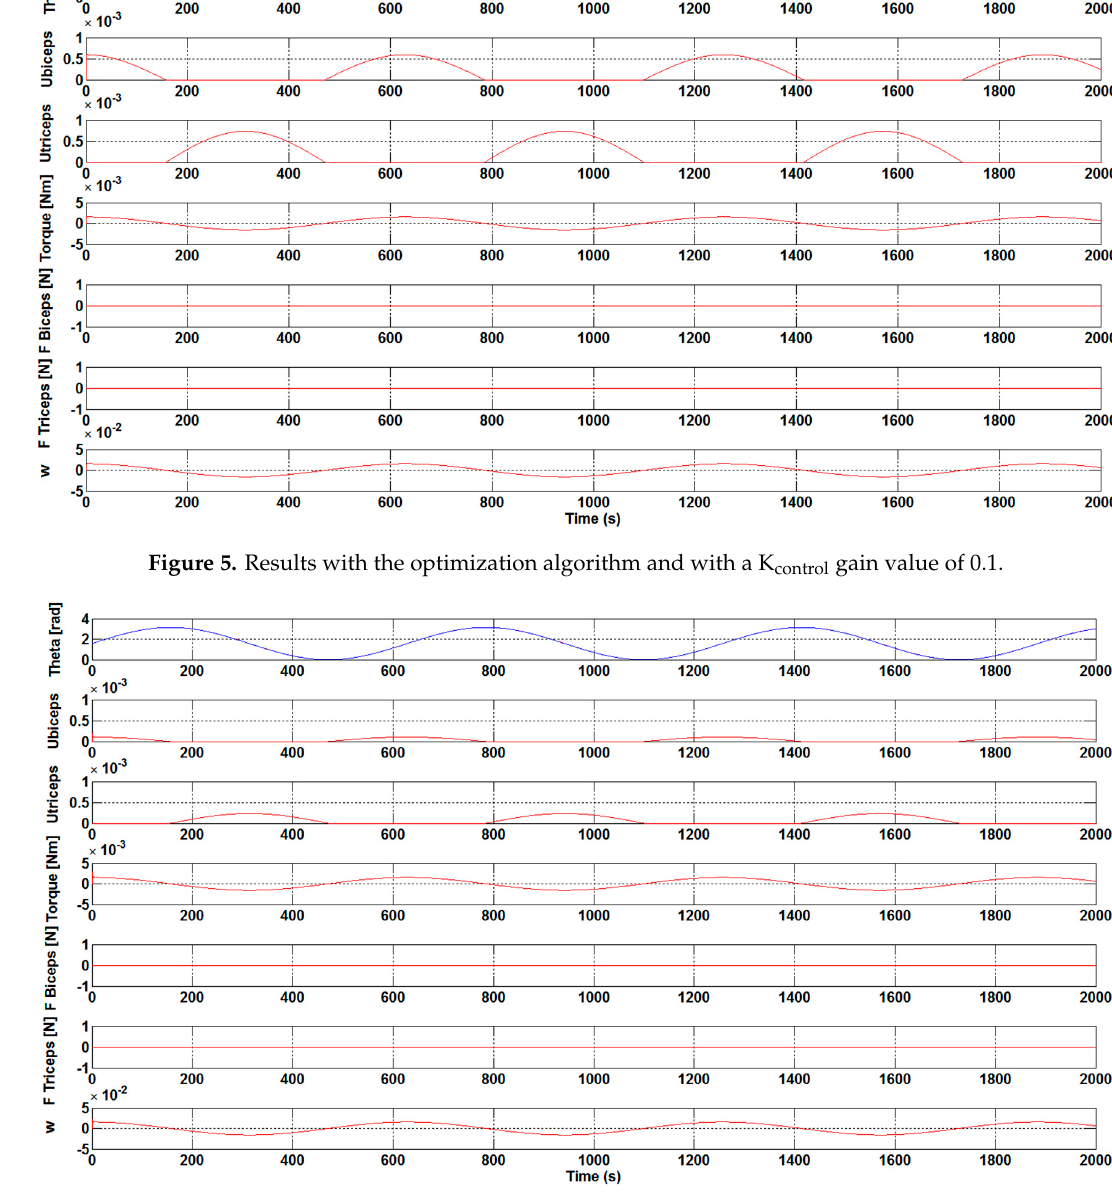
Figure 6. Results with the optimization algorithm and with a K control gain value of 0.3.